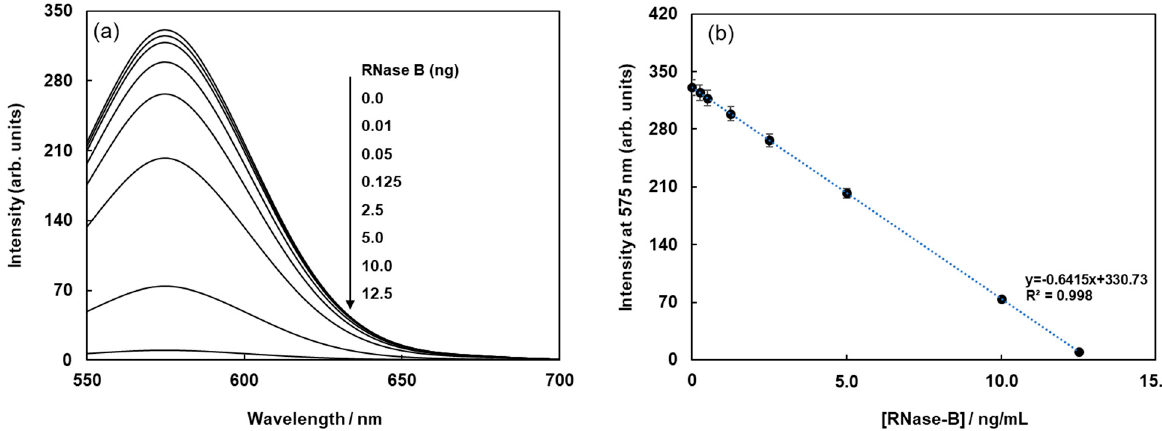
Figure 2. Fluorescence spectra of FMB-Con A before and after the addition of RNase-B modified using Quen-I ( a ), and plots of the fluorescence intensities of FMB-Con A at 575 nm against the concentrations of RNase-B modified using Quen-I ( b ). [FMB-Con A] = 10 μ g/mL; [RNase-B] = 0 ~ 12.5 ng/mL; Solvent, PBS buffer solution, pH 7.0; Excitation wavelength, 550 nm.